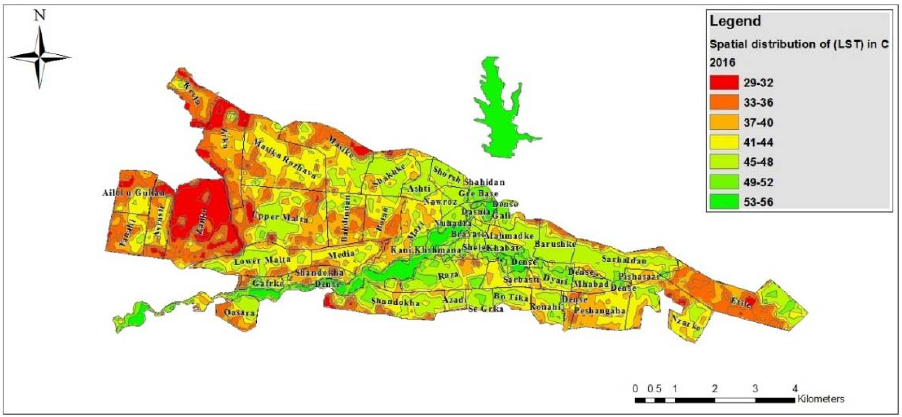
Figure 7. Spatial distribution of land surface temperature (LST) for 2016.